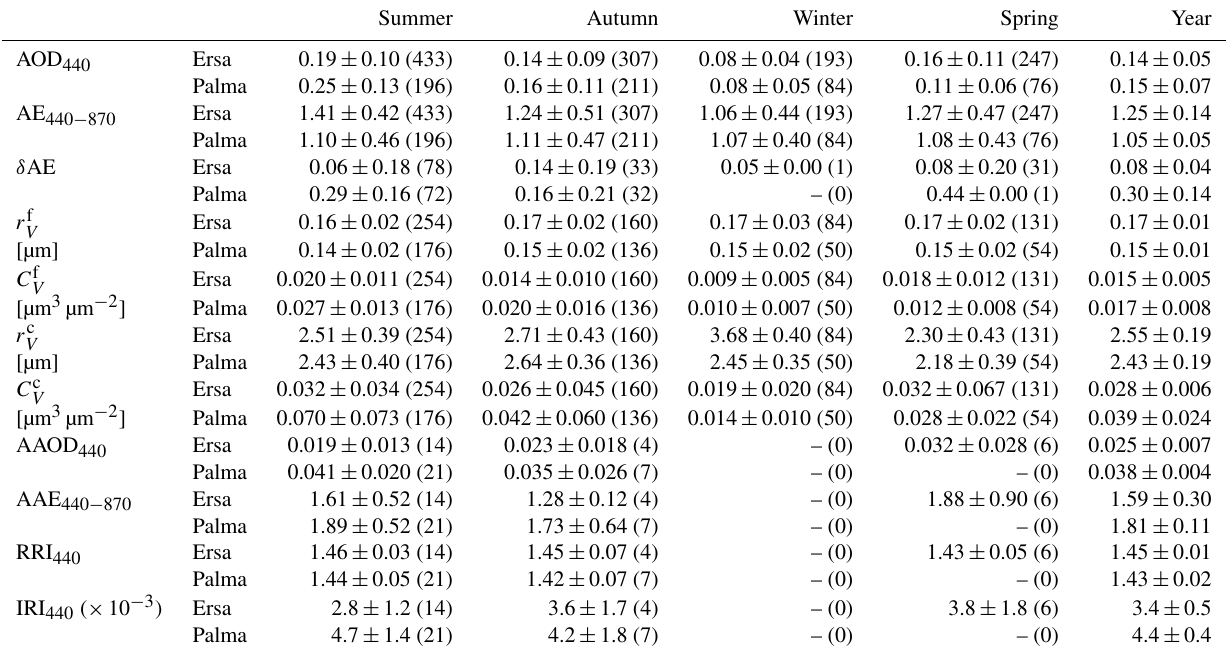
Table 1. Seasonal and annual variations of the following aerosol properties with their standard deviation (and number of observations in parenthesis): aerosol optical depth at 440nm (AOD 440 ) , the Ångström exponent calculated between 440 and 870nm (AE 440 − 870 ) , the ) and concentration (C f ) , the Ångström exponent difference ( δ AE = AE 440 − 675 –AE 675 − 870 ) , the fine-mode volume median radius (r f V V ) and concentration (C c ) , the aerosol absorption optical depth at 440nm (AAOD 440 ) , the absorption coarse-mode volume median radius (r c V V Ångström exponent (AAE 440 − 870 ) and the real (RRI 440 ) and imaginary (IRI 440 ) part of the refractive index at 440nm at Ersa and Palma de- rived from AERONET level 2.0 daily inversion products available for the period 2011–2015. The values of δ AE are given for AOD 675 >0.15 as suggested by Gobbi et al. (2007). The values of AAOD 440 , AAE 440 − 870 , RRI 440 and IRI 440 are given for 50<solar zenith angle<80 ◦ and AOD 440